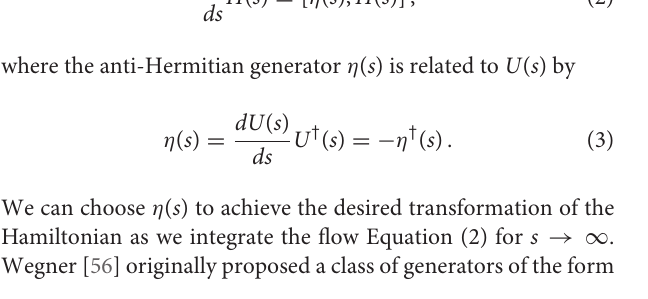
transformations that adapt a many-body Hamiltonian or other observables of interest to our needs, e.g., to extract eigenvalues [11, 53], or impose specific structures on the operator [1, 26, 27, 54,